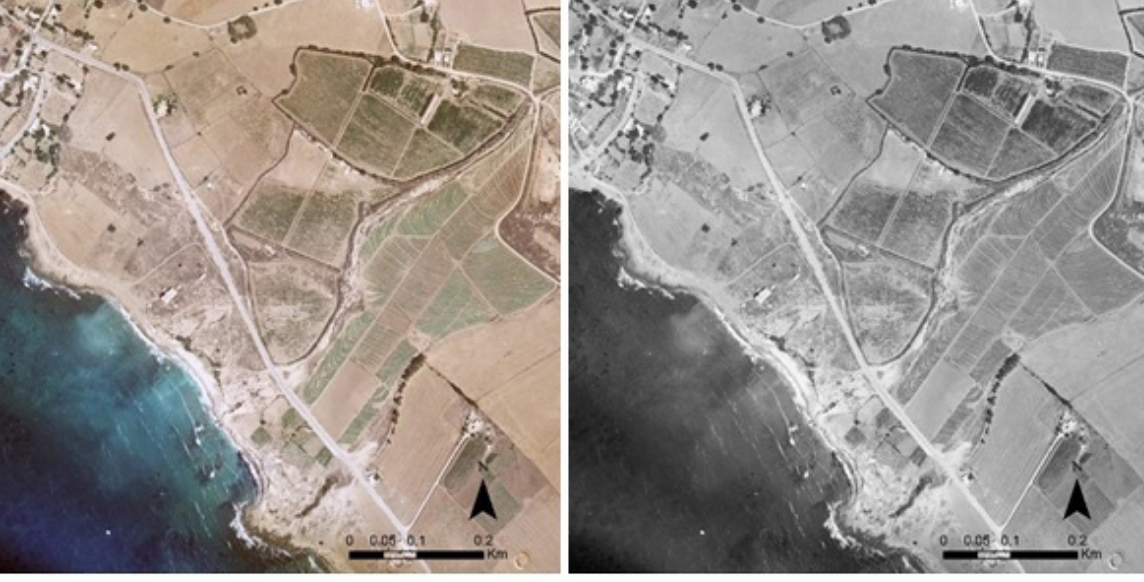
Figure 3: Geometrically corrected aerial photograph of 1968, showing the wider area of the Eastern necropolis. (RGB left; grey scale right). (Original photo source: Historic Environment